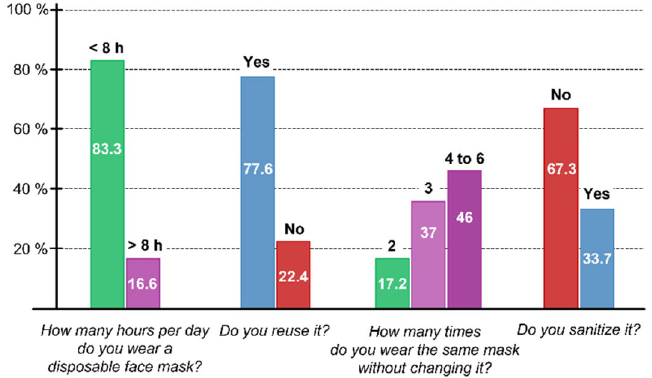
Figure 1. Face masks wearing awareness